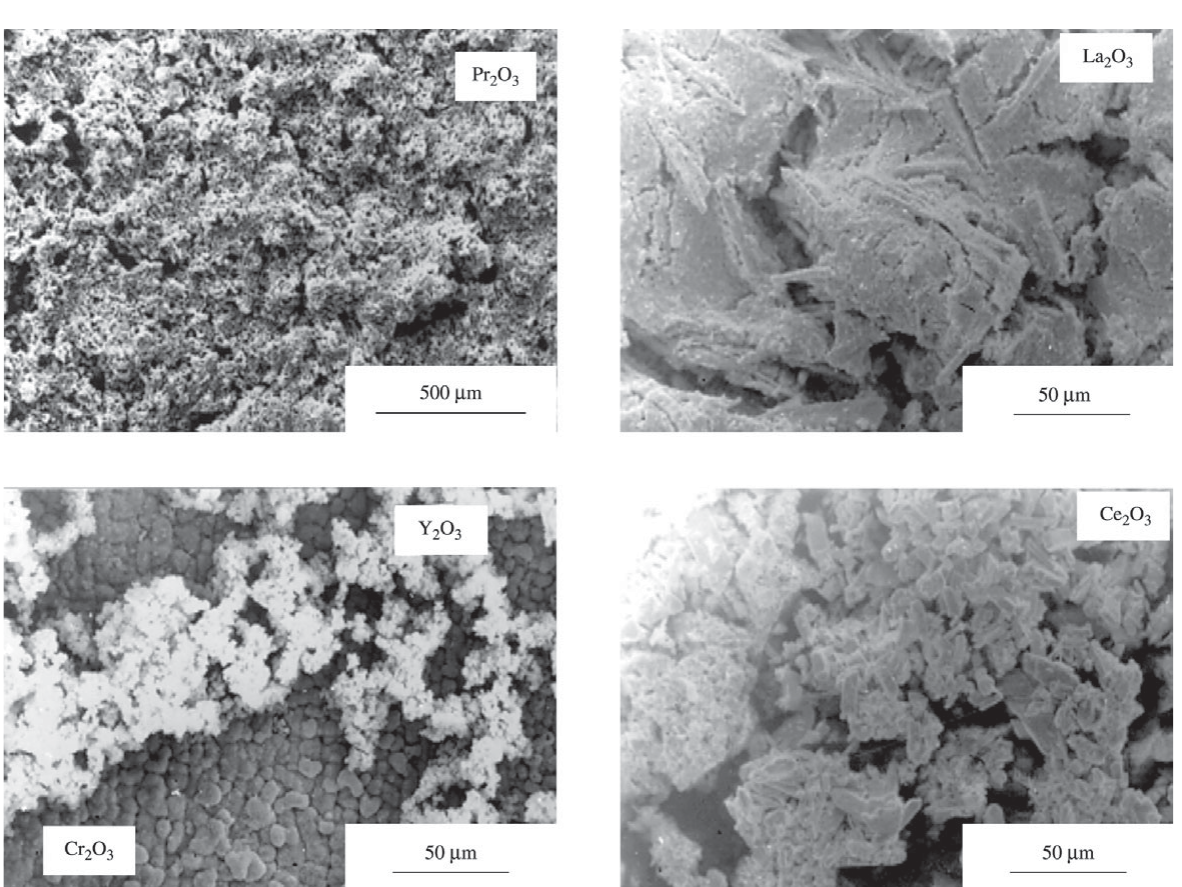
Figure 1. Scanning electron micrographs of Fe-20Cr substrates with given coatings after oxidation at 1000 °C for 40 h.